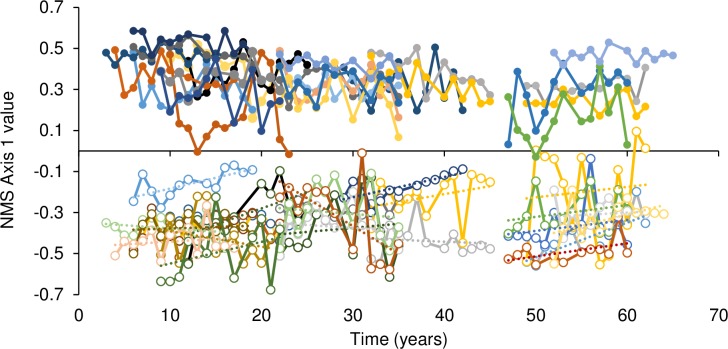
NMS axis 1 scores (species matrix) over time.Data from ex-arable fields shown with open symbols and data from never-tilled fields shown with filled symbols. Data from transects located 50 m from tillage boundaries. Positive y-axis values were associated with native, long-lived perennial communities (Table 1; Fig 1). NMS 1 values increased with time during 13 years of observation in ex-arable fields, but did not change with time in never-tilled communities or across the chronosequence in either community type.